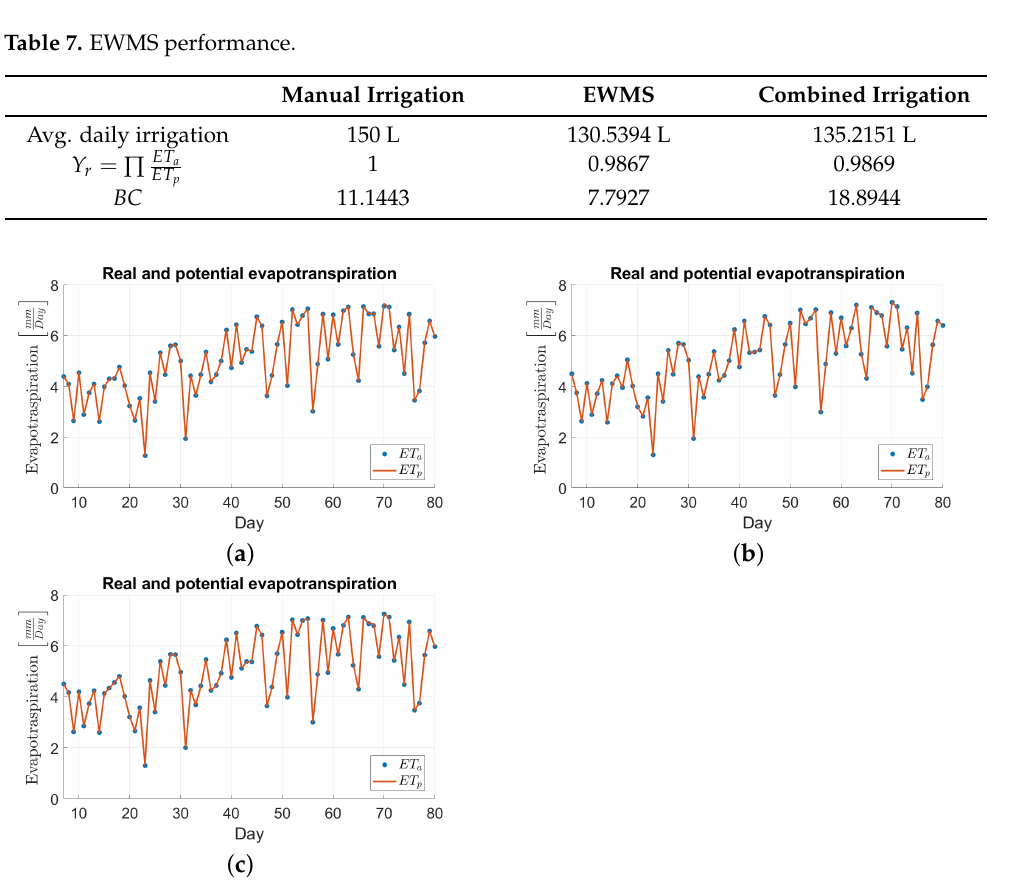
Figure 12. Comparison between real and potential evapotranspiration ET a and ET p when considering different irrigation scenarios. The real evapotranspiration is indicated by blue points, and potential evapotranspiration is represented by red lines. ( a ) Real and potential evapotranspiration ET a and ET p in the EWMS case; ( b ) real and potential evapotranspiration ET a and ET p in the shared manual irrigation case; ( c ) real and potential evapotranspiration ET a and ET p in the combined irrigation